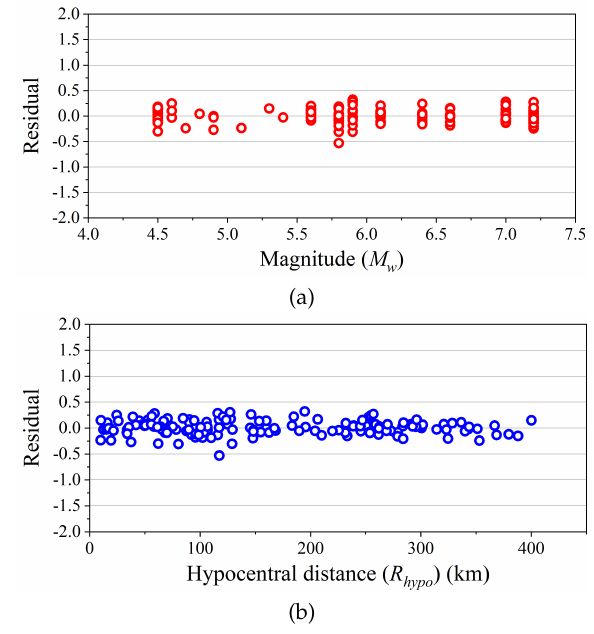
Fig. 7. Distribution of residuals between the actual and predicted log 10 D s 5 − 95% for the proposed ANN model with respect to (a) Magnitude, and (b) Hypocentral distance.